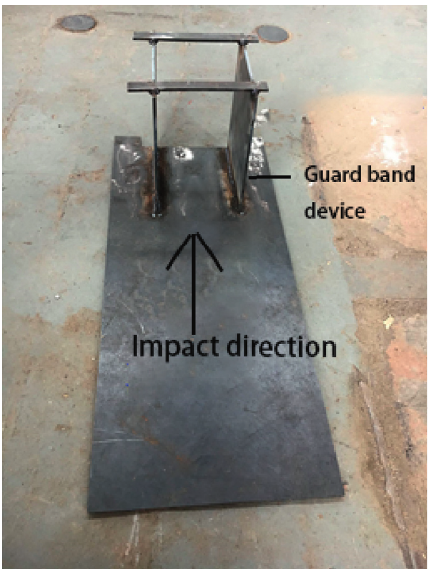
Figure 14: Guard band device.